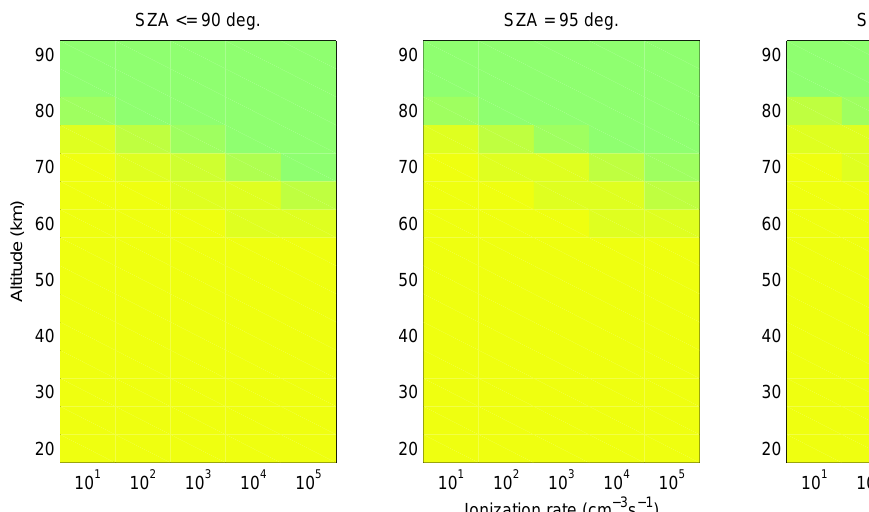
/Q for October 2